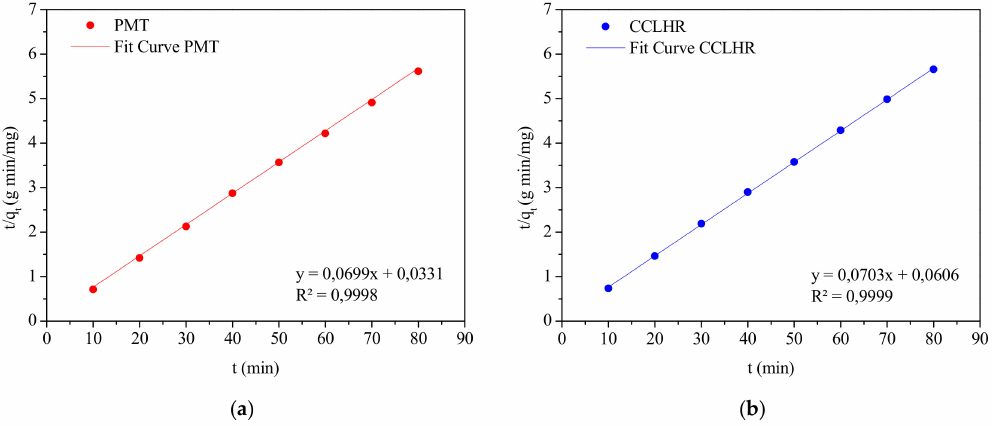
Figure 12. Plots of pseudo-second-order kinetic model for the biosorption: ( a ) PMT and ( b )